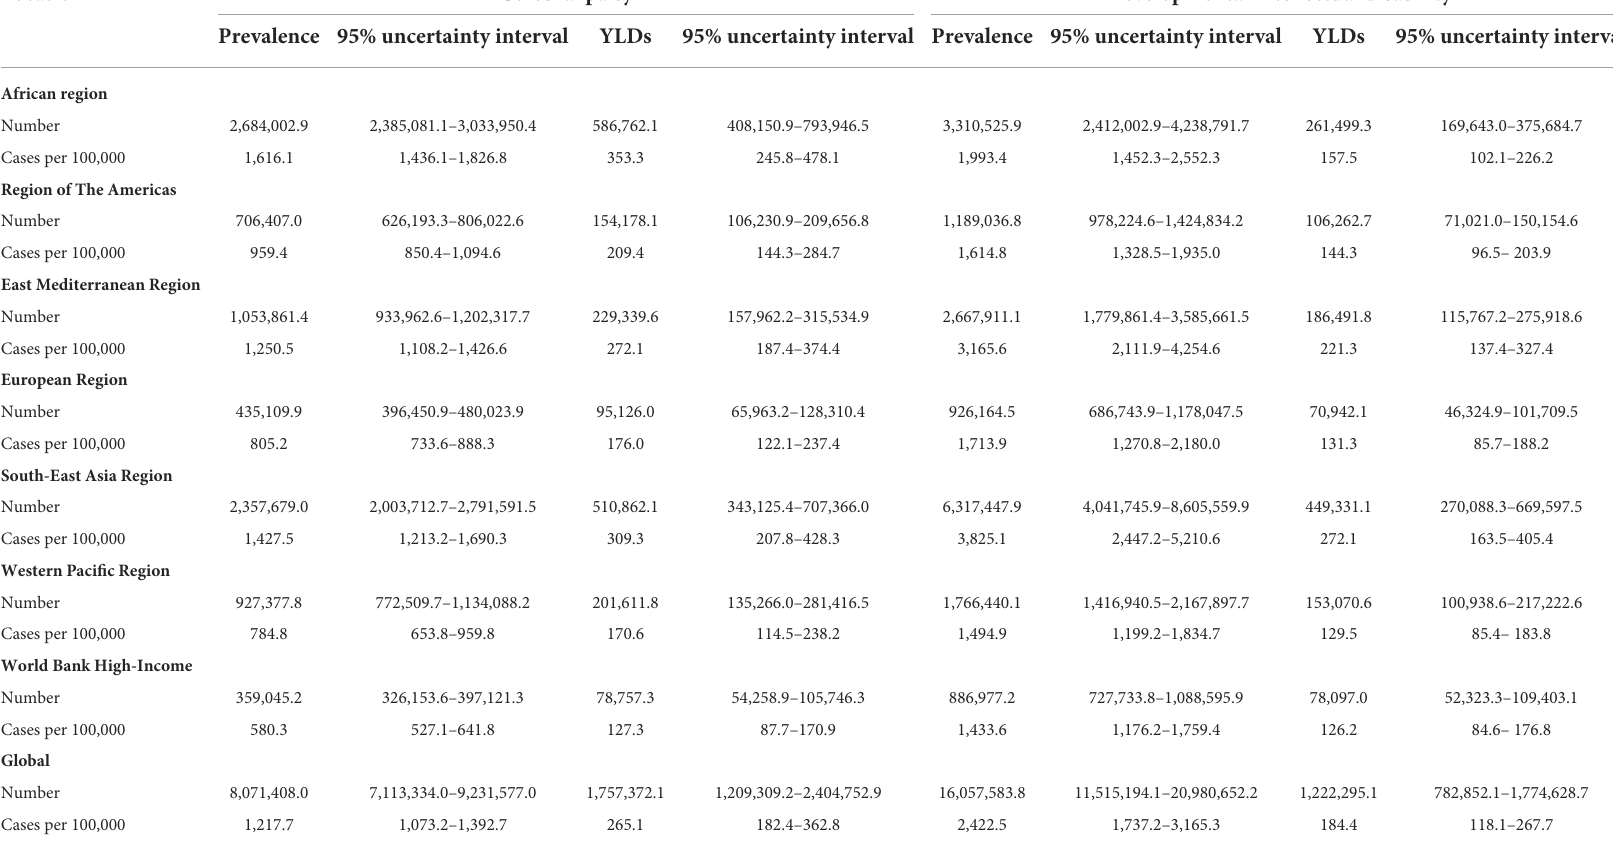
TABLE 1 Global and regional prevalence of cerebral palsy and developmental intellectual disability and the YLDs among children under 5 years in 2019.